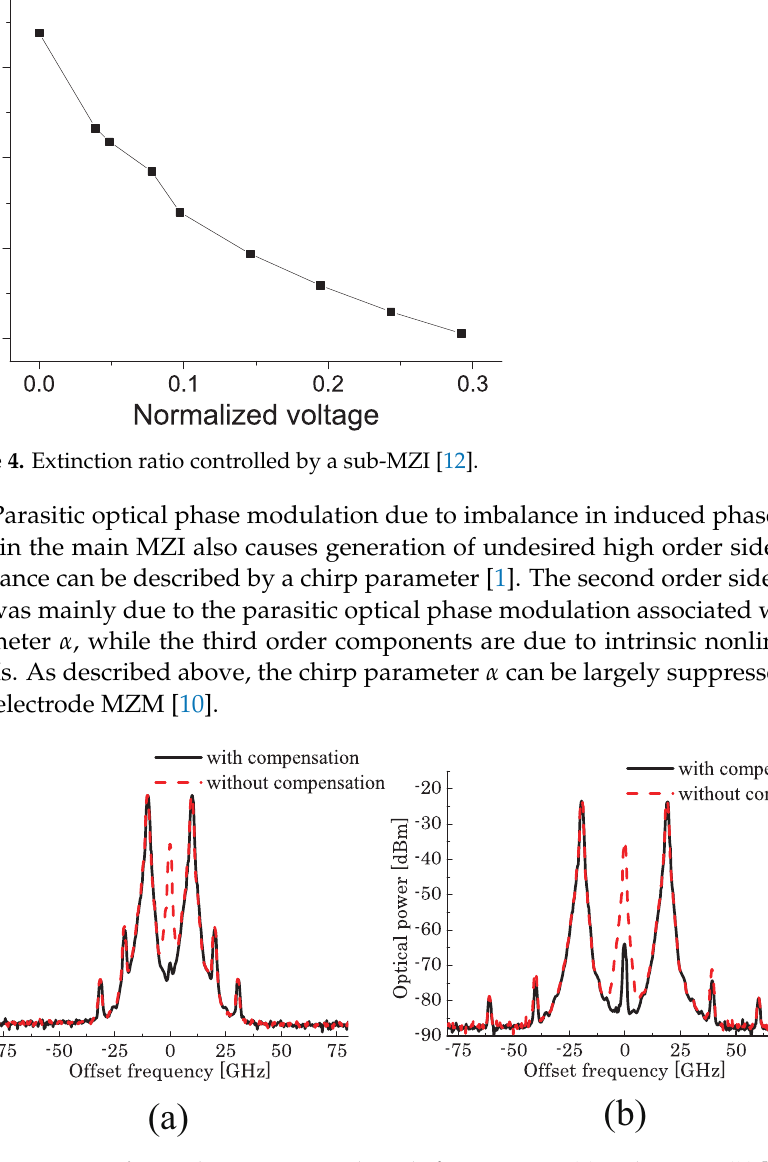
Figure 5. Spectra of optical two-tone signals with f m =10.5 GHz ( a ) and 20 GHz ( b ) [1]. By using a high-speed photodetector, the optical two-tone signal can be converted into a pure single-tone electric signal as a beat signal of the two optical spectral components whose frequency separation is equal to 2 f m . Figure 6a,b show wide span (DC-50 GHz) spectra of the RF signal generated from the optical two-tone signal ( f m = 20.0 GHz). with and without the compensation technique, respectively, where resolution bandwidth was 43 kHz. By using active trimming, the spurious suppression ratio could be larger than 60 dB without using any electrical or optical filters for suppression of undesired components, where the suppression ratio without using active trimming was 21.0 dB. The linewidth of the generated millimeter-wave signal was almost equal to that of the modulating